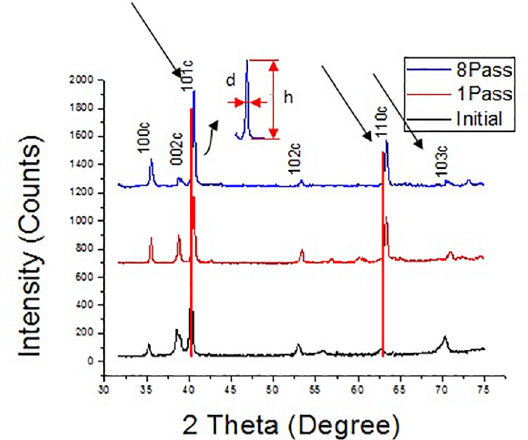
Figure 8. XRD profiles of samples processed by ECAP with 1 pass and 8 passes, including initial state